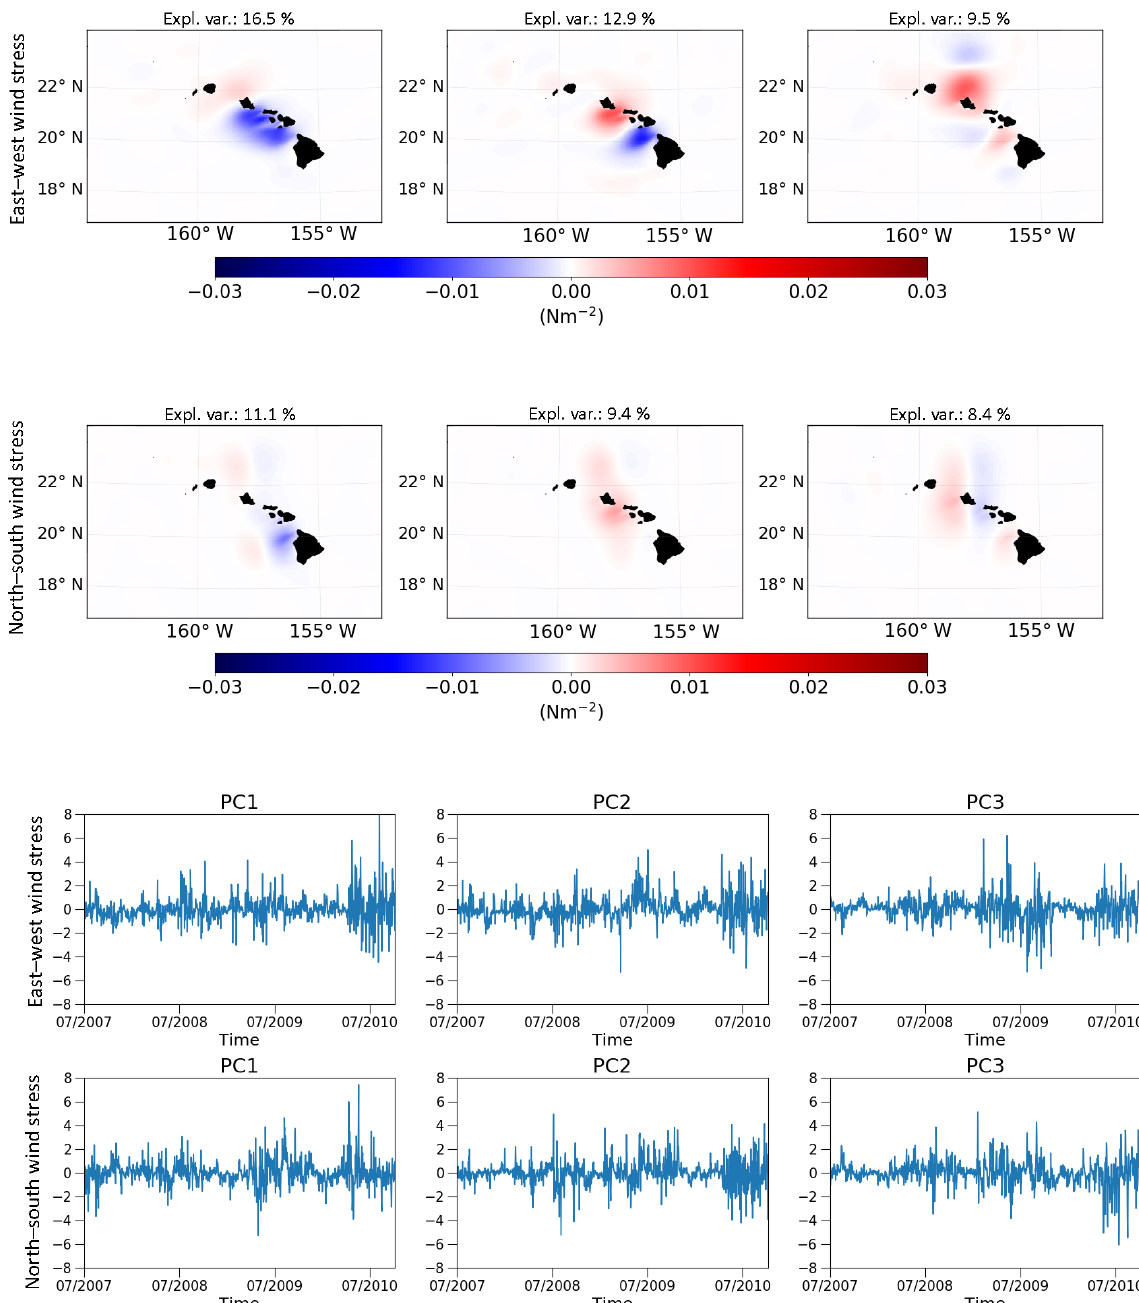
Figure 14. Spatial EOF patterns and principal components (PCs) of wind stress perturbations for the period prior to the assimilation of HFR measurements (June 2007–September